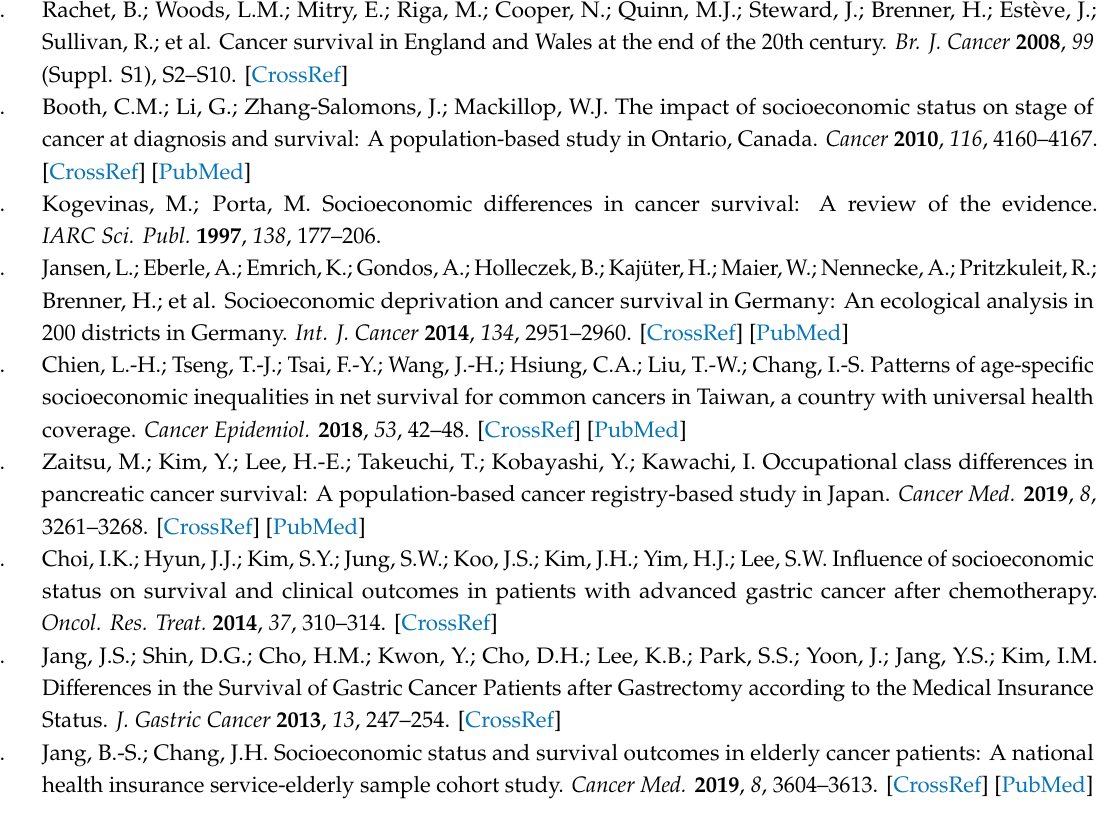
Table S1: Overall HRs and their 95% CIs according to occupational groups using Cox proportional hazard model. adjusted for age and year of diagnosis, Table S2: Results of univariate analysis of cancer-specific survival for all cancer